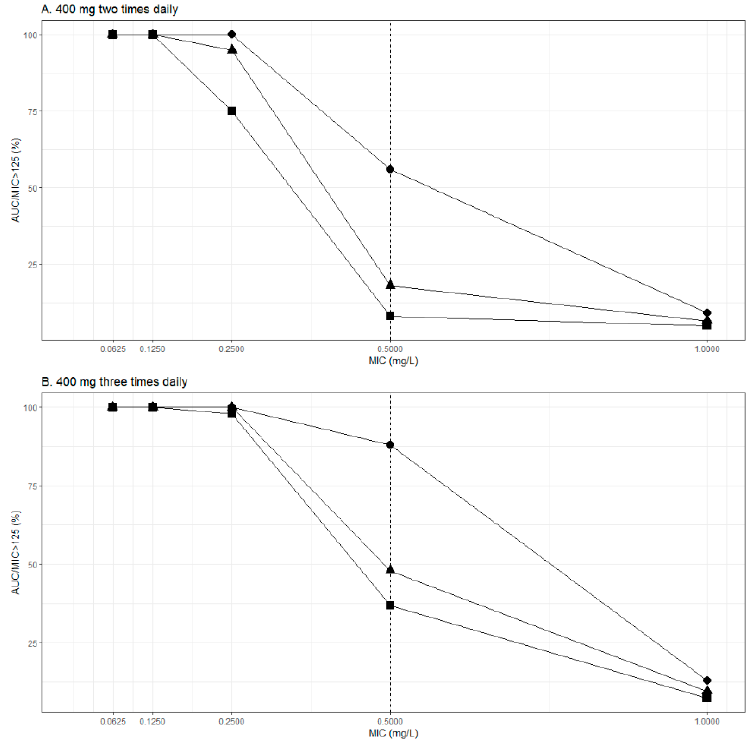
Figure 4. Monte Carlo simulations for ciprofloxacin PTA (AUC/MIC > 125) at different creatinine clearance (CL CR ) values. ( A ) 400 mg two times daily and ( B ) 400 mg three times daily.